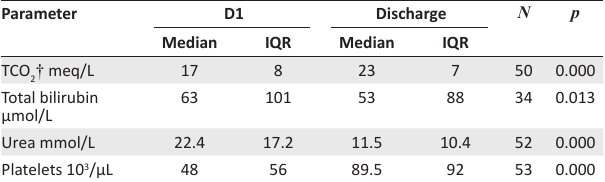
TABLE 4: Changes in the indicators of severe malaria from admission (D1) to discharge or death (DC) using Wilcoxon matched pairs test or T -test for dependent